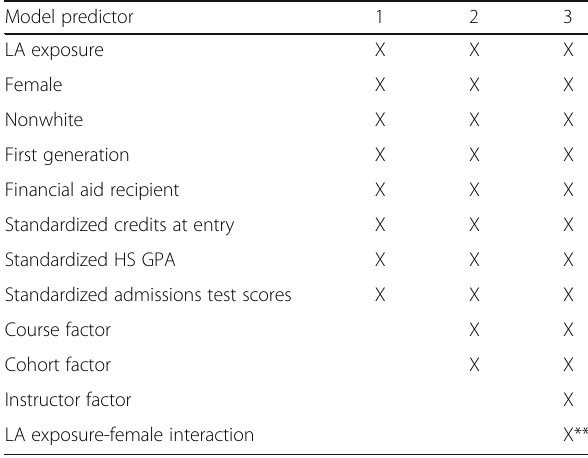
Table 2 Logistic regression model